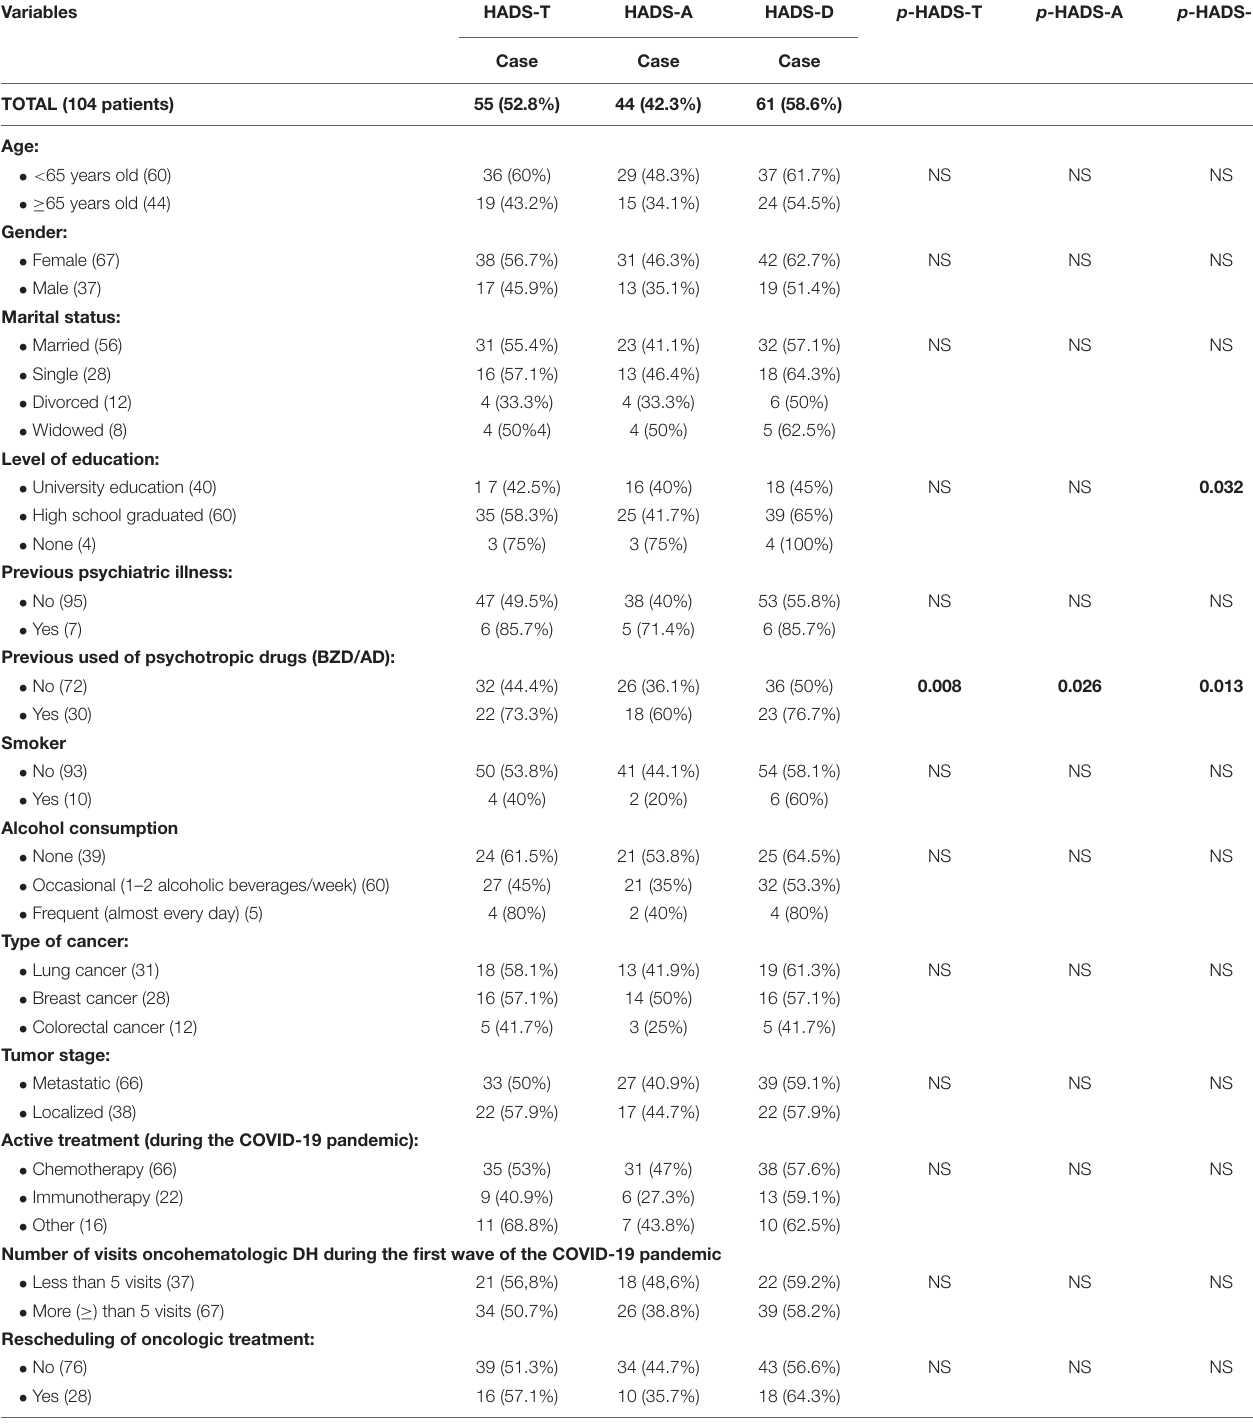
TABLE 3 | Baseline characteristics (sociodemographic, comorbidity, and oncologic disease) and existence of emotional distress, anxiety, and depression (HADS scale). Variables HADS-T HADS-A HADS-D p- HADS-T p- HADS-A p- HADS-D Case Case Case TOTAL (104 patients) 55 (52.8%) 44 (42.3%) 61